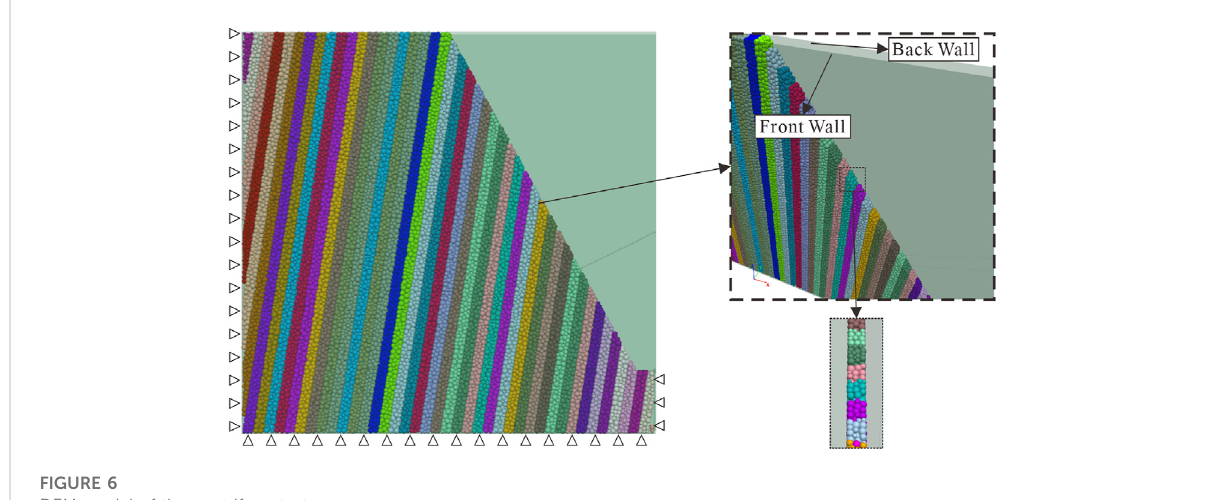
FIGURE 6 DEM model of the centrifuge test.